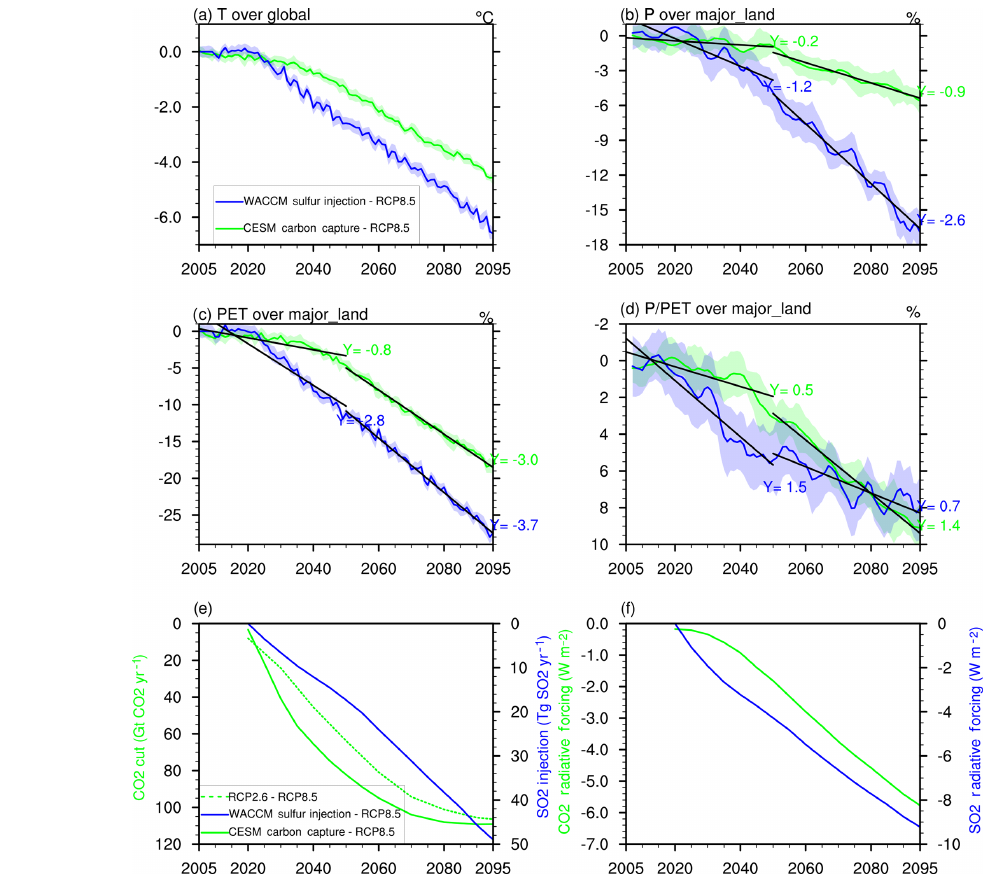
Figure 4. The changes in T , P , PET, and P / PET due to two types of geoengineering schemes. The changes are shown in relative terms (except for T in degrees Celsius), which are computed from the absolute values in Fig. 3. In panel (d) , the linear fit for the blue and green lines (separately for 2005–2050 and 2050–2095) is to highlight the near-term benefit of sulfur injection. (e) The mass of carbon cuts (GtCO 2 yr − 1 ) and sulfur injection (TgSO 2 yr − 1 ). The dashed green line is the RCP2.6 carbon cut for comparison; (f) the radiative forcing (Wm − 2 ) due to carbon capture and sulfate injection. The mass of carbon cuts and corresponding radiative forcing are based on Fig. 1 of Sanderson et al. (2017). The mass of sulfur injection comes from Fig. 2 of Tilmes et al. (2018). The sulfate radiative forcing is calculated based on the equations in Metzner et al.